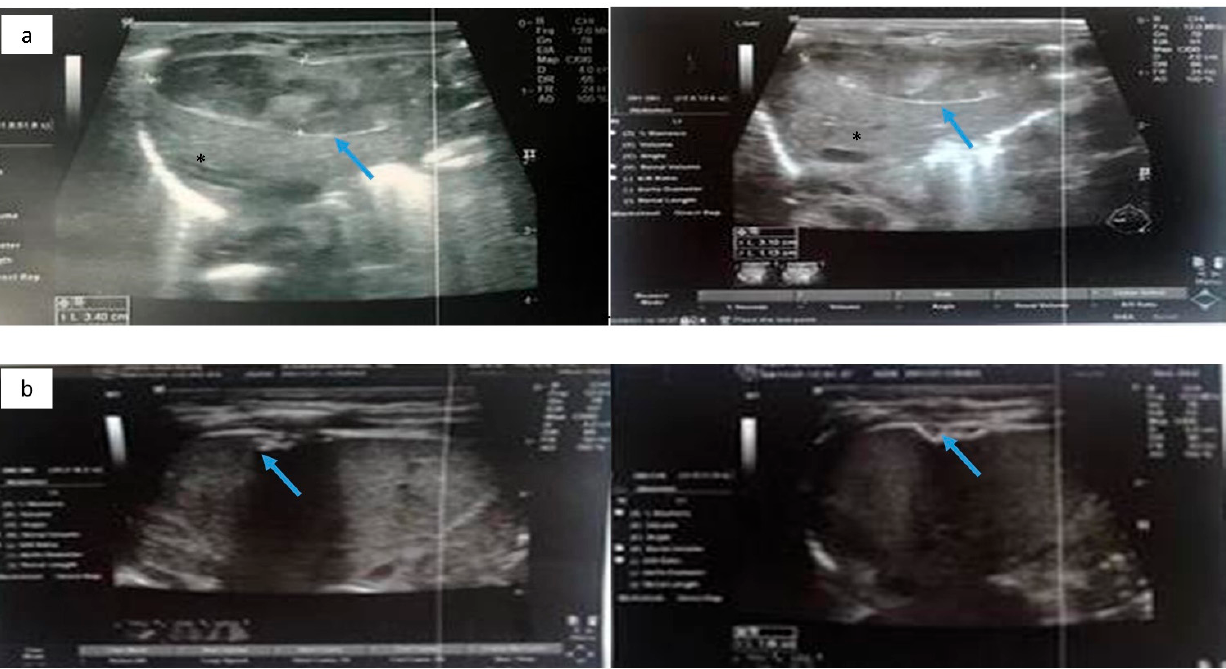
Figure 8. ( a ) Abdominal ultrasonography depicting hypoechogenic intrahepatic irregular lesion on the right lobe (3.4 cm × 1 cm) (blue arrow); and ( b ) abdominal ultrasonography depicting the calcific deposits (1 cm × 1 cm) (blue arrow) at the right lobe of the liver. Normal liver parenchyma is noted with asterisk (*).